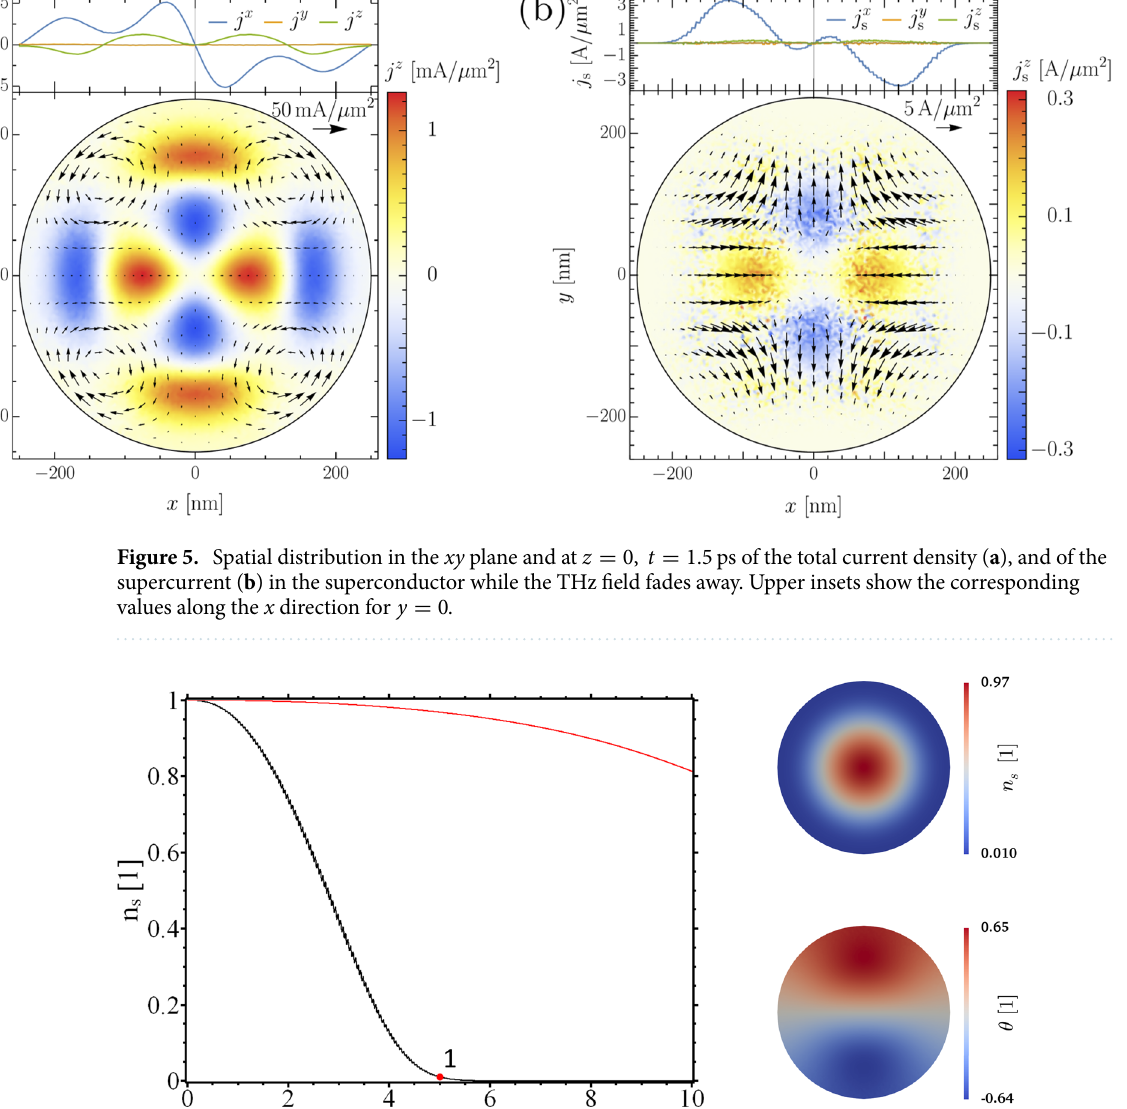
Figure 6. Left: The minimum (black curve) and maximum value (red curve) of the local density of Cooper pairs n s under the influence of the plane-wave vector potential. Right: Snapshot of n s and θ at z 100 ps indicated by a red dot in the left